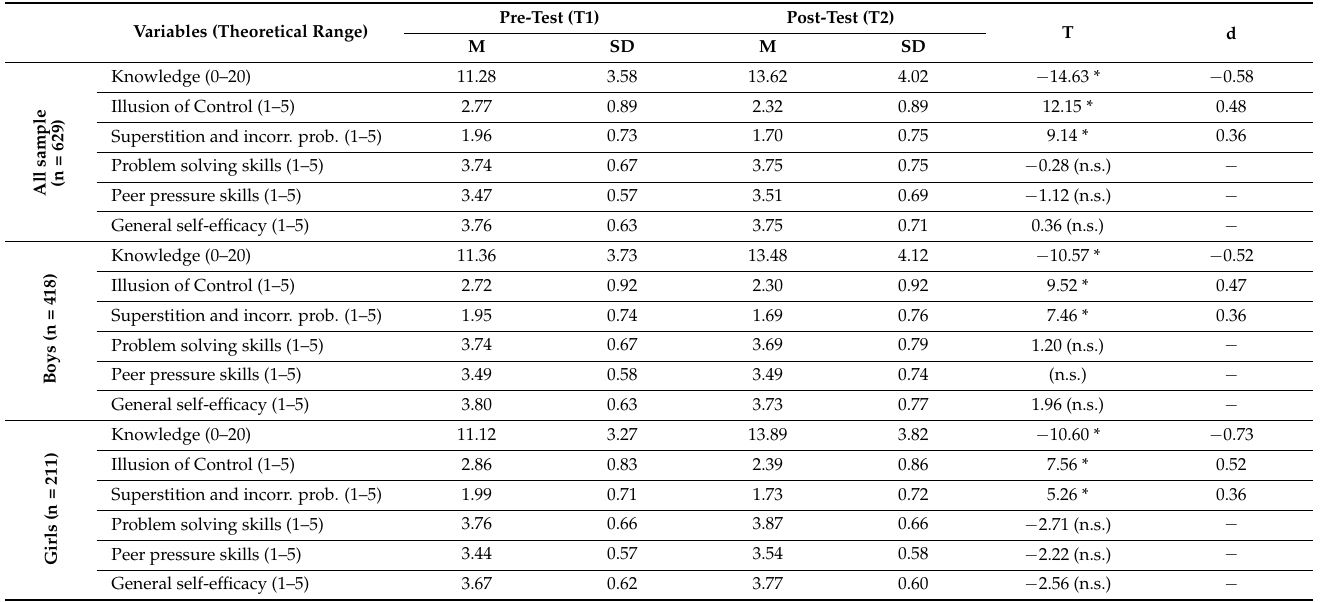
Table 3. Mean scores compared with paired-samples t -tests at pre- and post-test (short-term effectiveness). Pre-Test (T1) Variables (Theoretical Range)